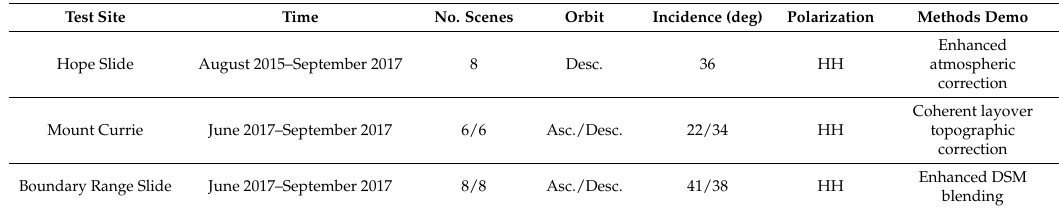
Table 2. Test sites and TerraSAR-X Staring Spotlight dataset (ascending (Asc.)/descending (Desc.)). (Incidence angles are expressed in degrees (deg), HH polarization refers to Horizontal transmit and Horizontal receive, and DSM is Digital Surface